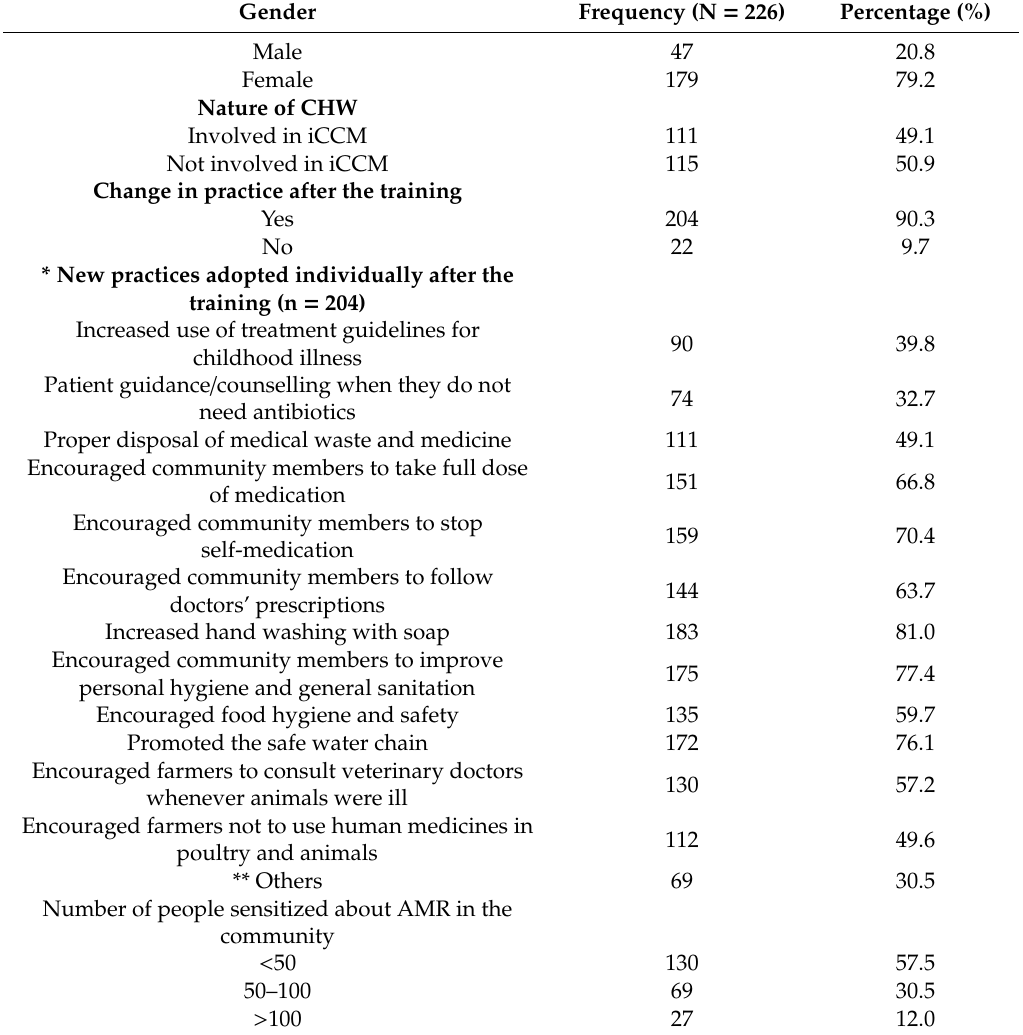
Table 2. Evaluation results of community health